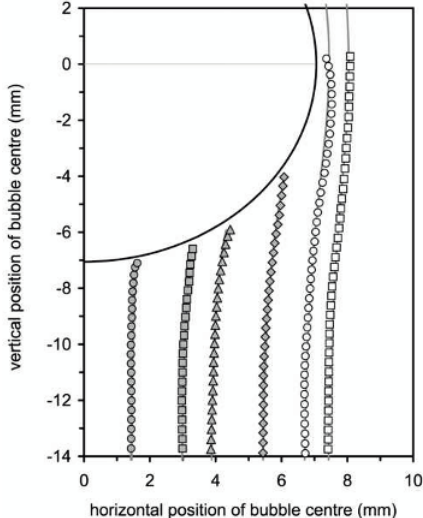
Fig. 2. Example of observed and computed trajectories of bubble. Velocity of the ball is 50 mm / s, bubble diameter 0.596 mm, pure